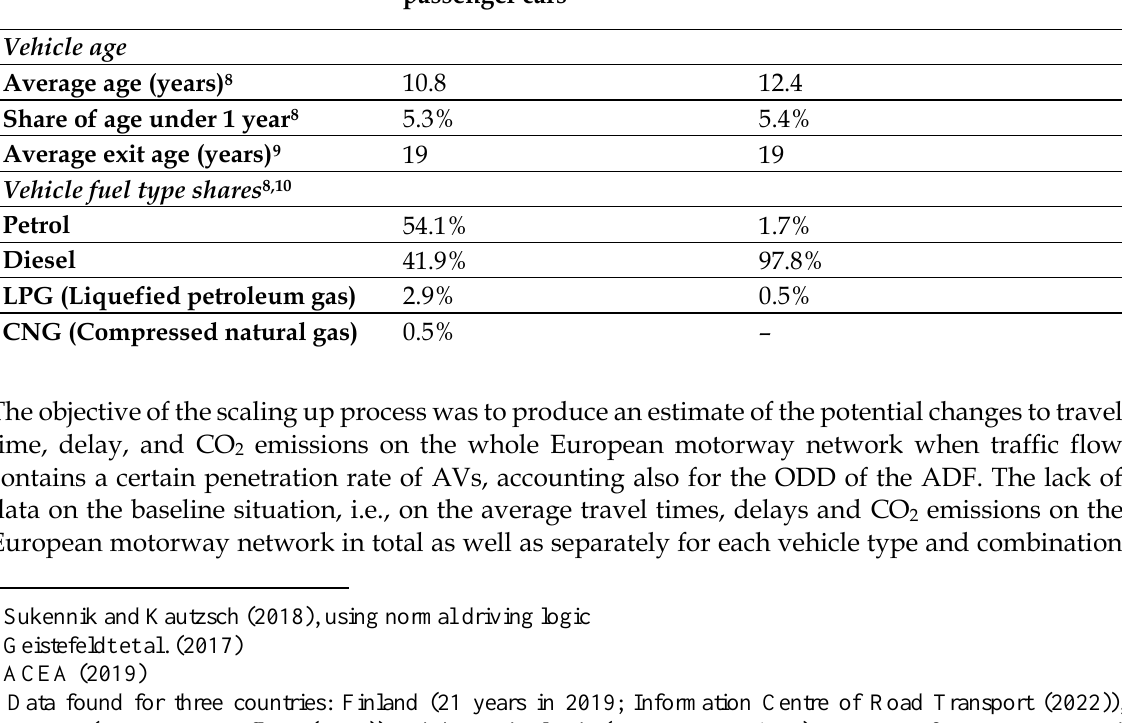
Average vehicle characteristics of the European